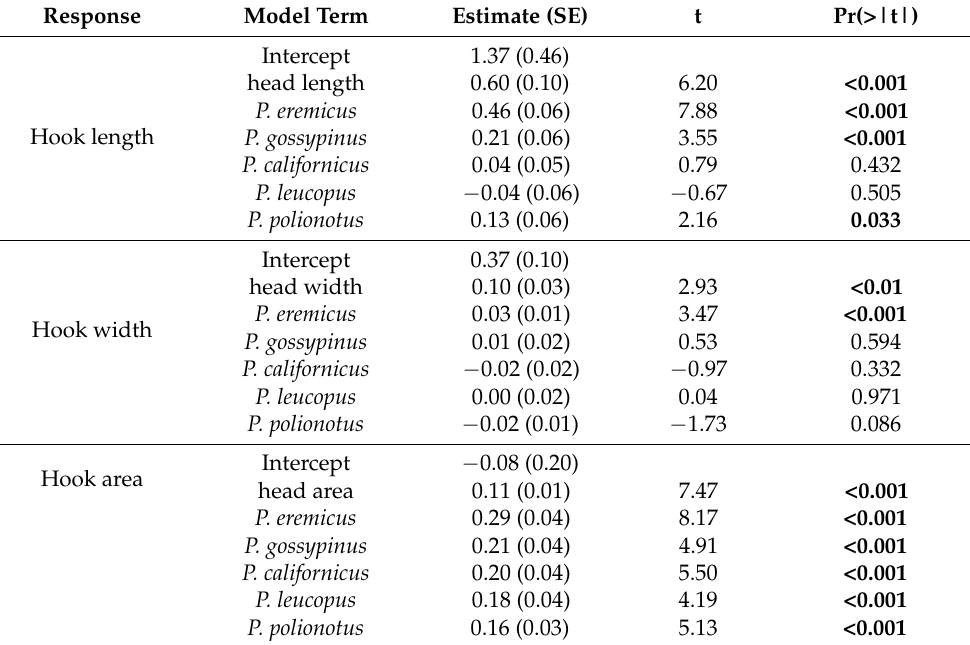
Table 1. Fixed effects from linear models examining differences in sperm hook morphology across six Peromyscus species.